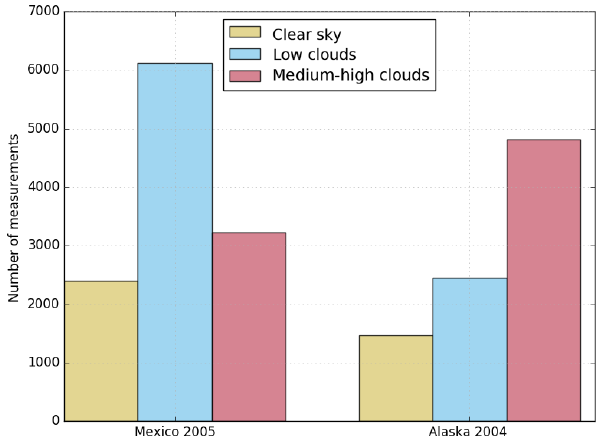
Figure 6. Number of individual SCIAMACHY CO retrievals under clear-sky (yellow), low-cloud (blue) and medium–high-cloud (pink) atmospheric conditions for the time range and latitude–longitude box specified in Figs. 3 and